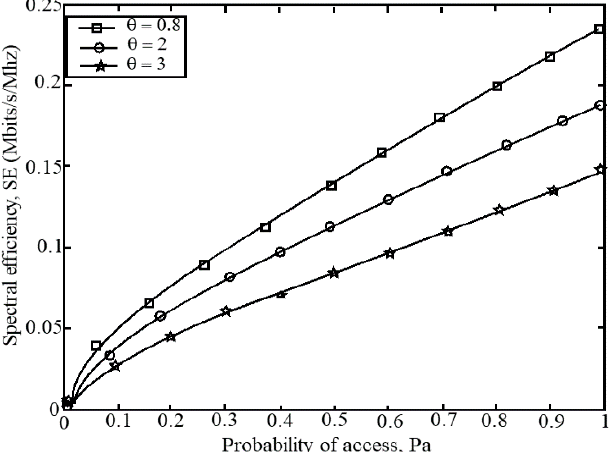
Figure 10. Representation of the SE when the detection power is considered in the CCRNs as a function of the probability of access to different detection factors θ